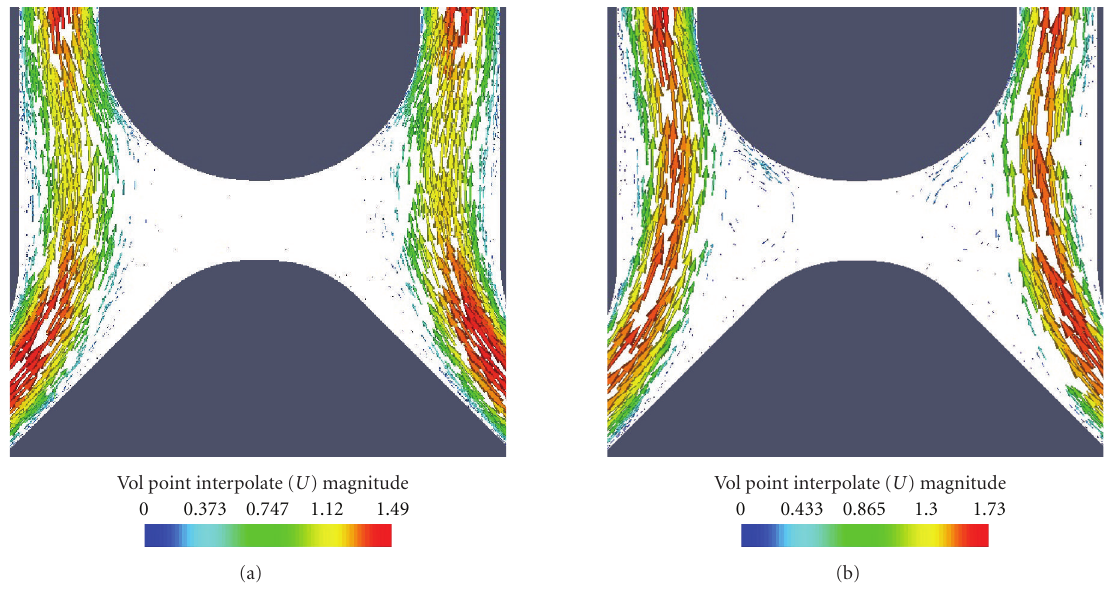
Figure 3: Velocity field with equal left and right ACA flow rates ( Q R = Q L ) during (a) systole and (b) early diastole. A dead zone in the ACOM exists throughout the pulsation cycle. (b) Unsteadiness exists bilaterally at the A2-ACOM impingement sites with flow separation and vortices seen during the diastolic